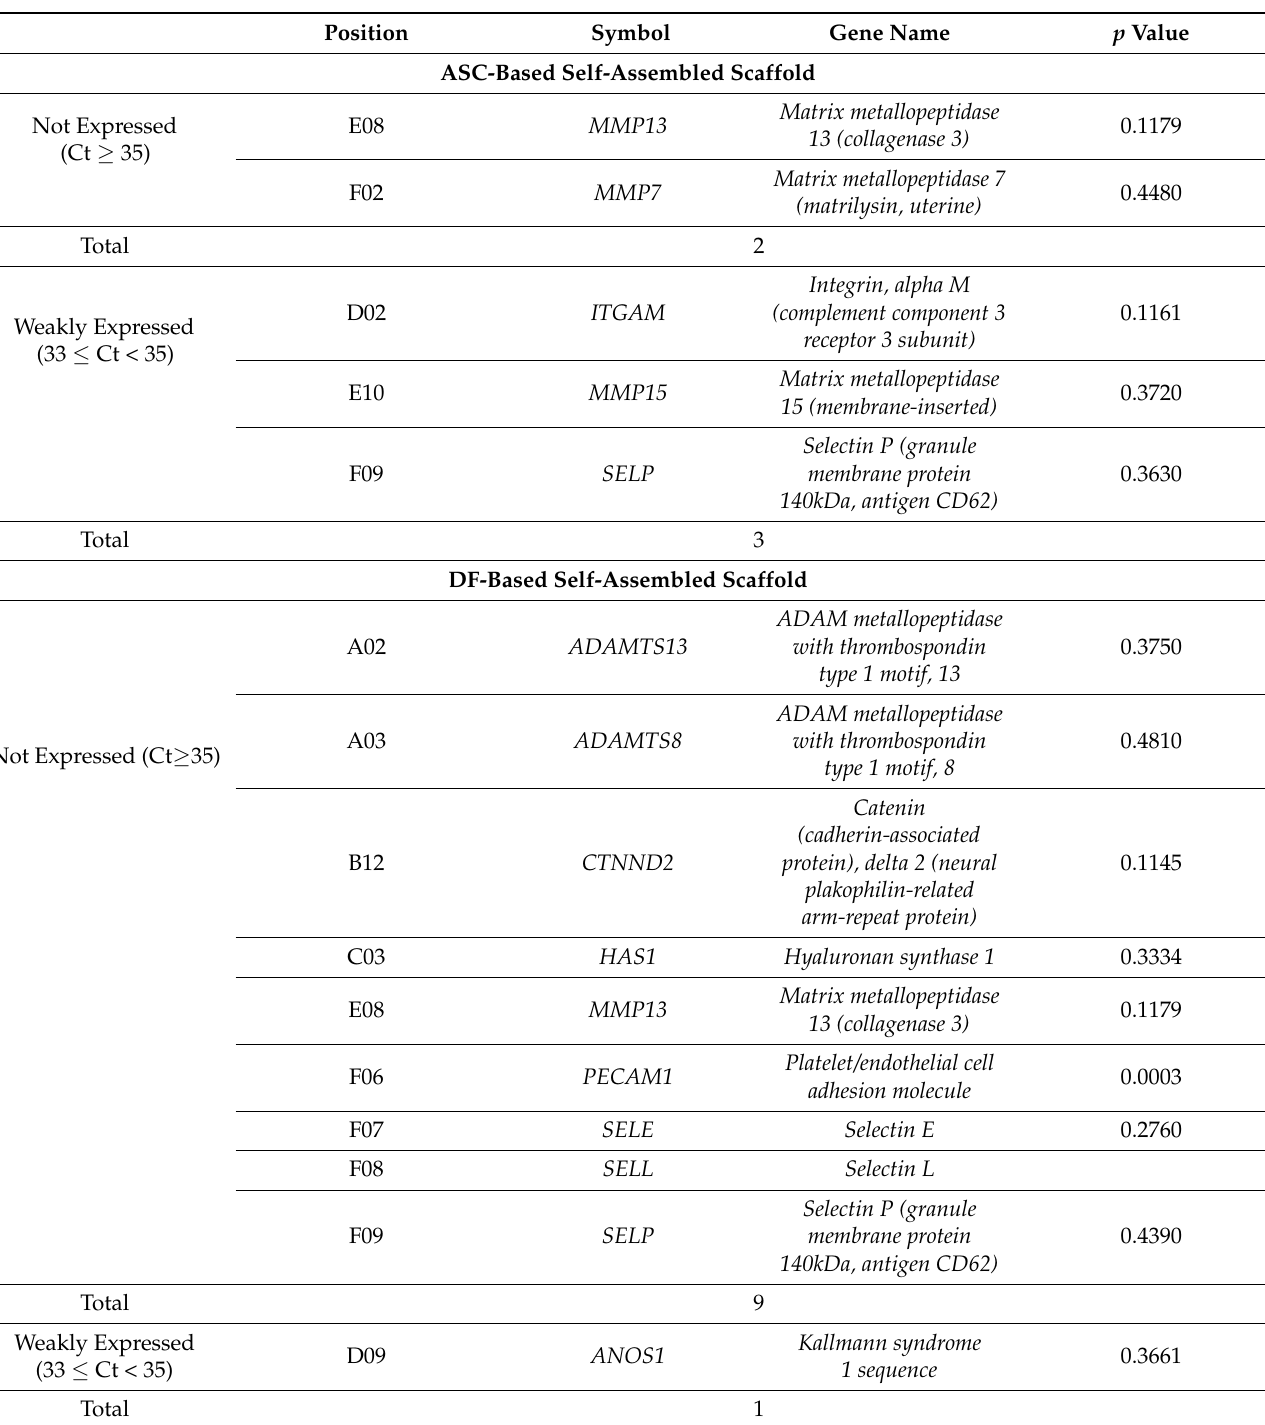
Table 2. List of the genes not expressed or weakly expressed in ASC-based and DF-based self-assembled scaffolds. Position Symbol Gene Name p Value ASC-Based Self-Assembled